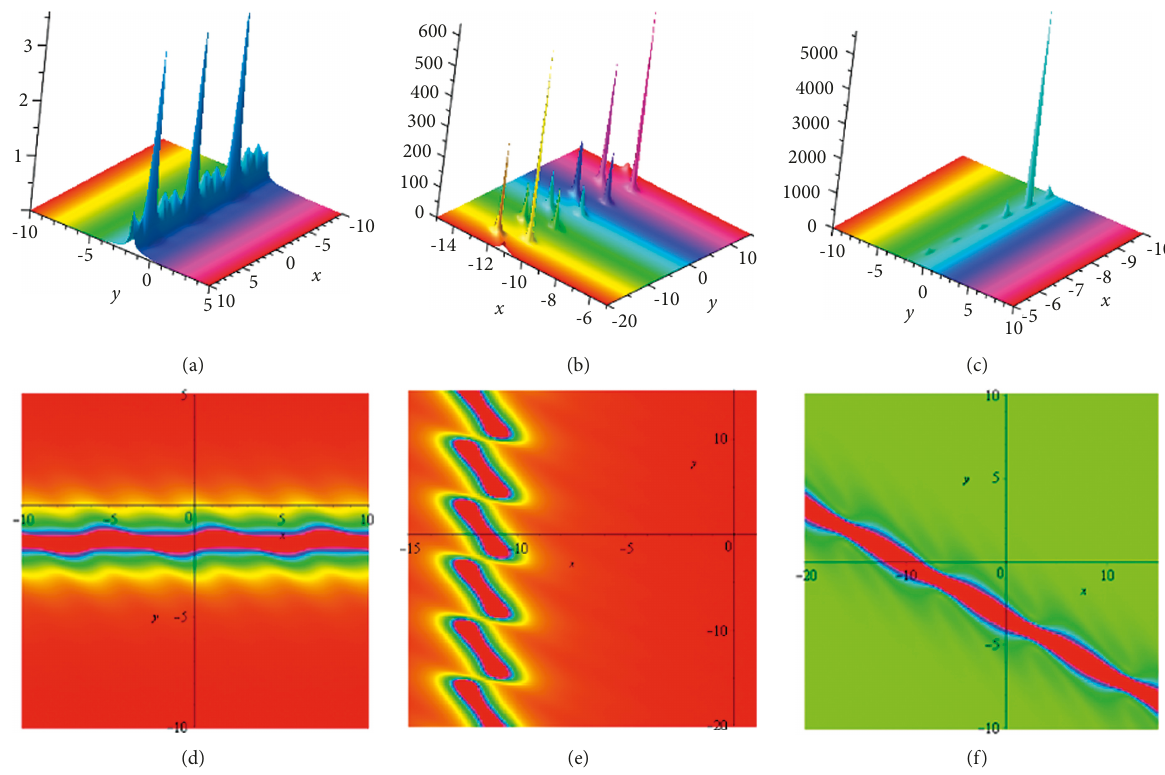
� 1 , c � 1/10 , t � − 2. (a) f 1. (b) f 2. (c) f 3. (d) f 4. (e) f 5. 0 1